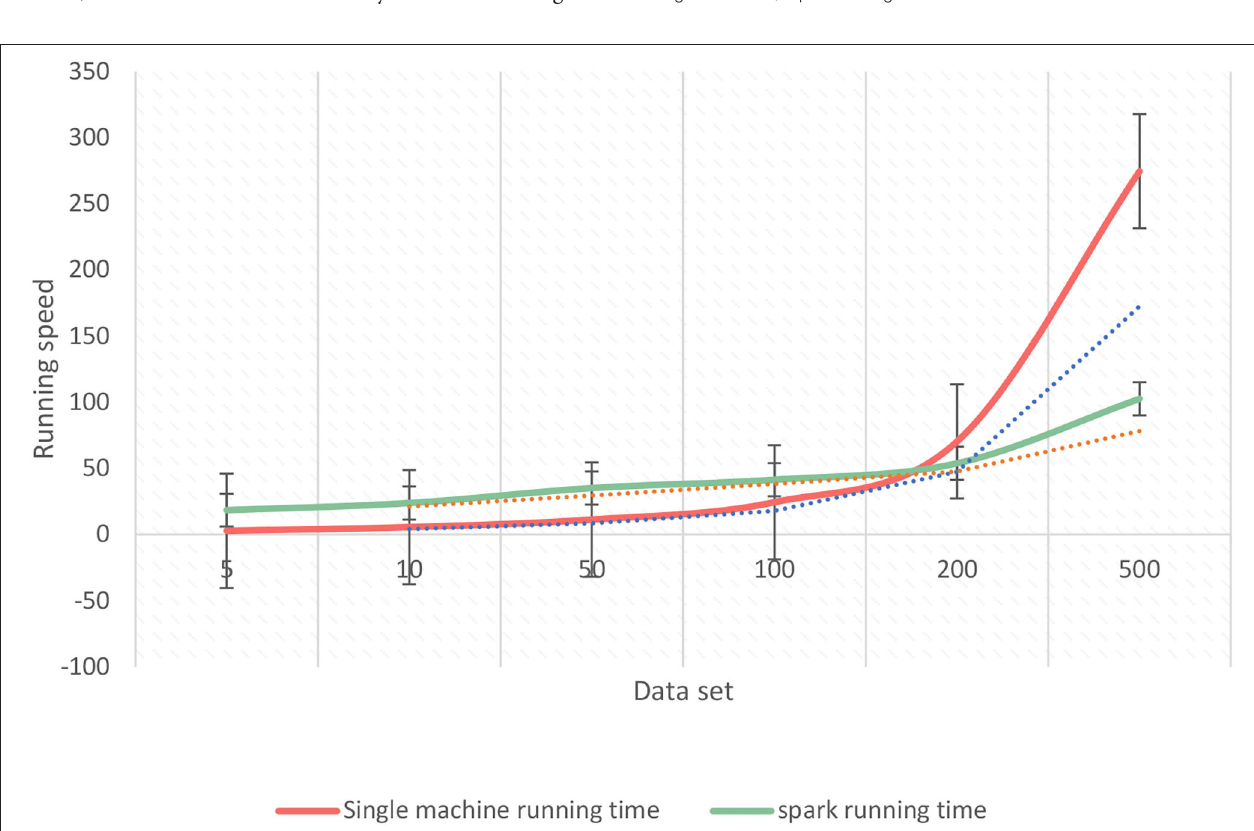
FIGURE 8 | Comparison of running time of different scale data